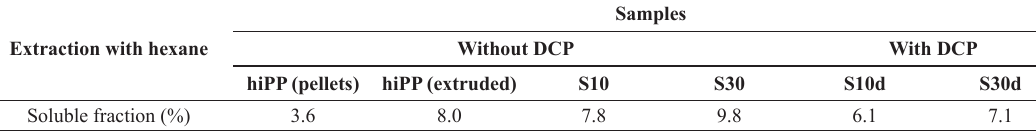
Table 3. Extraction with hexane of halloysite composites.